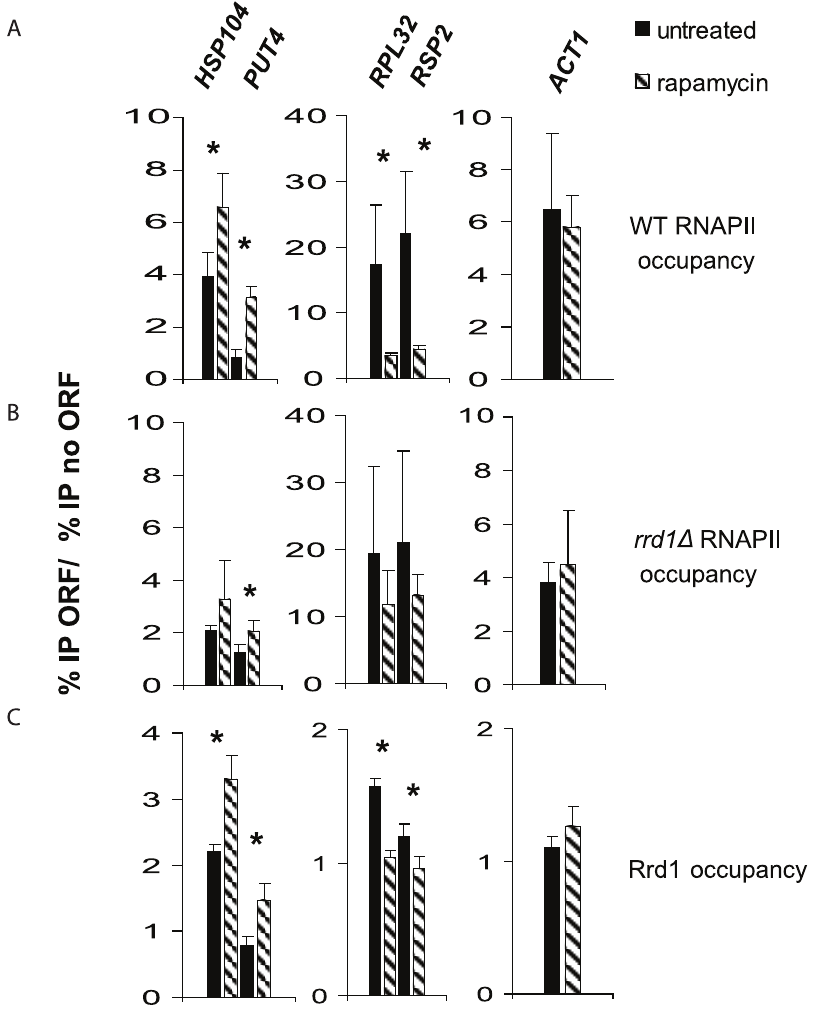
Figure 1. Rrd1 affects RNAPII occupancy on rapamycin responsive genes. ( A ) ChIP of Rpb1 (RNAPII) from WT cells followed by Q-PCR on the indicated genes. Dashed bars indicate rapamycin treatment (100 ng/ml for 30 min). The data is represented as a ratio of the % IP over Input on the ORF compared to % IP over Input in a non transcribed region (noORF). ( B ) ChIP of RNAPII from rrd1 D mutant cells performed as in panel A. ( C ) ChIP of Rrd1-MYC (Myc antibodies) performed as in panel A. Results for all panels are shown as an average of at least three independent experiments, error bars indicate the standard deviation and the asterix ( * ) indicates if the P -value is below 0.05 between the untreated and treated condition using the Student T test.